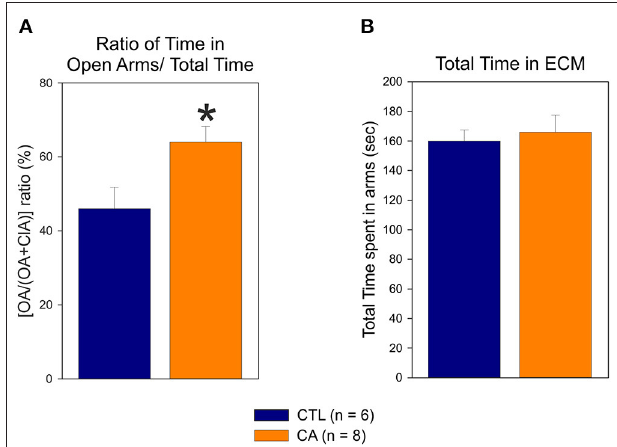
FIGURE 5 | Elevated Cross Maze test: the histograms represent the ratio of time spent in the open arms (OA) relative the total time spent in the maze (A) and the total time spent in both open and closed arms (ClA) (B) . Values are means ± SE obtained from 6 control (CTL, blue bar) and 8 cardiac arrest (CA, orange bar) animals. Asterisk indicates significant difference ( p < 0.05, Mann Whitney test).